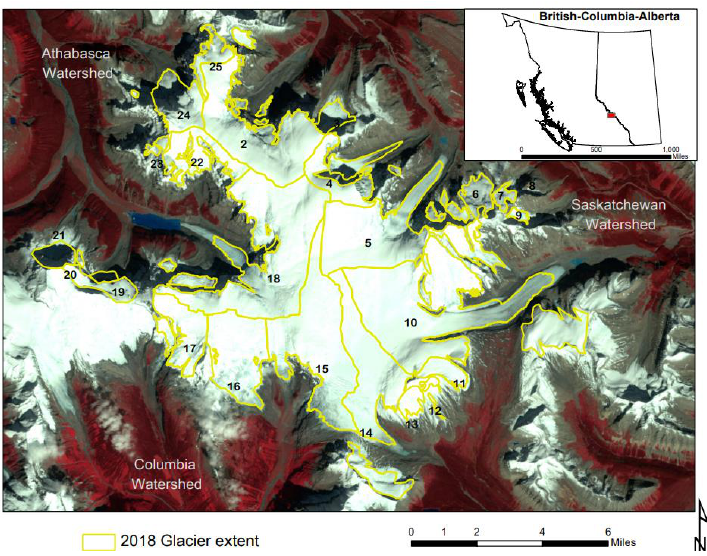
Figure 1. Study area. Landsat TM 5 scene obtained on 10 September 1999 showing the Columbia Icefield.